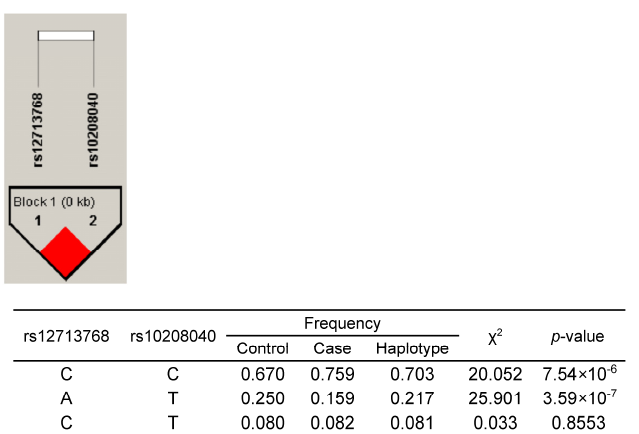
Figure 5. The linkage disequilibrium (LD) pattern (r 2 ) of the second strongest SNP signal, rs12713768, generated in Haploview. SNP rs12713768 has strong LD with rs10208040 (D’ = 1, r 2 = 0.651) in the Han Chinese population.